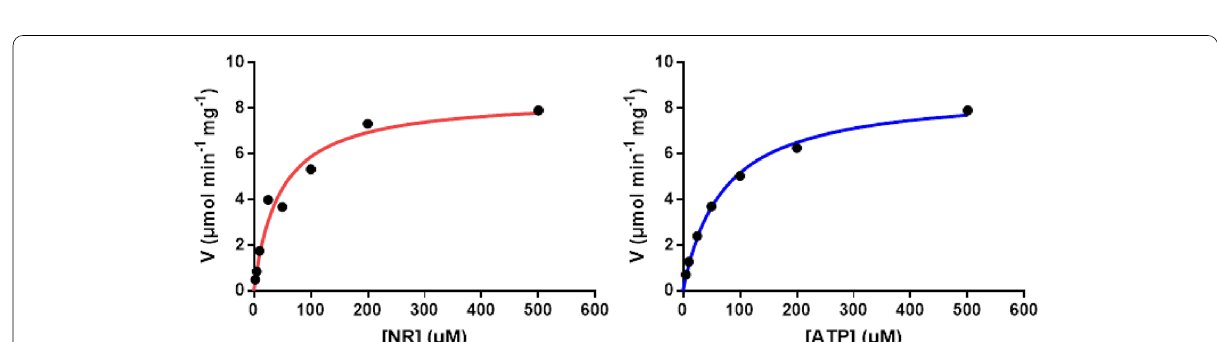
mg –1 (100%). B Activity–temperature profile. It was determined · mg –1 · mL –1 ) was preincubated in potassium phosphate buffer (100 mM, pH 7.0) at ·